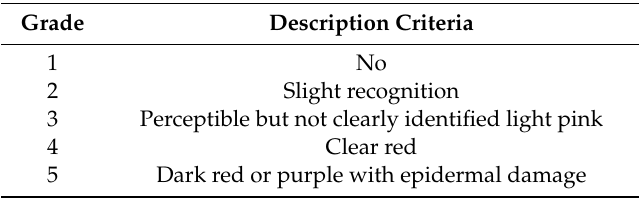
Table 1. Photo assessment for scalp redness